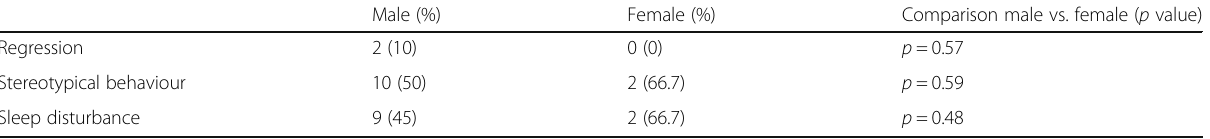
Table 2 Clinical profile of autistic children with epilepsy